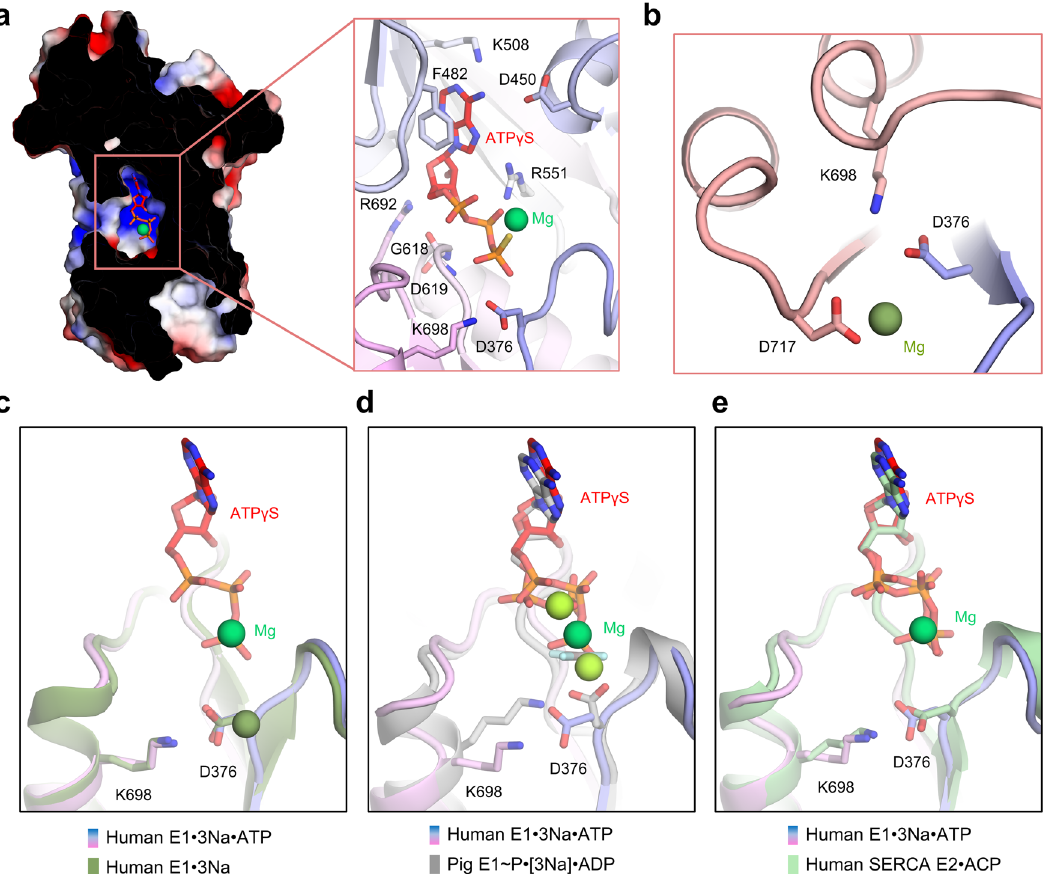
Fig. 3 ATP binding modes in NKA. a ATP binding pocket between the N and P domains and the key residues around ATP γ S (red). b Mg 2 + binding site and the phosphorylation site (Asp376) in the E1·3Na state. c Comparison of the Mg 2 + binding site and the phosphorylation site (Asp376) between the E1·3Na (dark green) and E1·3Na·ATP (blue to magenta) states. d , e Comparison of the ATP binding pocket between the E1·3Na·ATP (blue to magenta) and E1~P·[3Na]·ADP (grey) or SERCA E2·ACP (pale green) states. Mg 2 + are coloured forest green, green and pea green in E1·3Na, E1·3Na·ATP and E1~P·[3Na]·ADP,